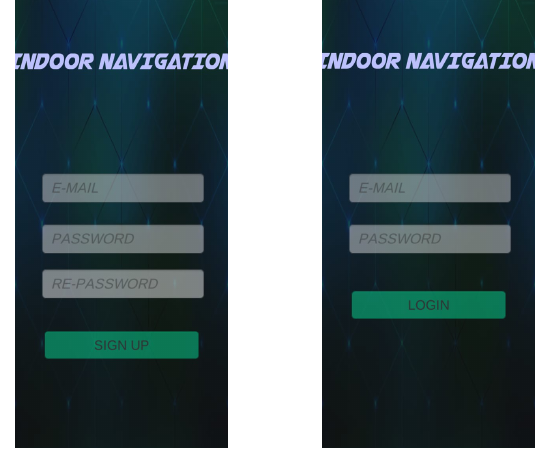
Figure 6. Available destina- tions